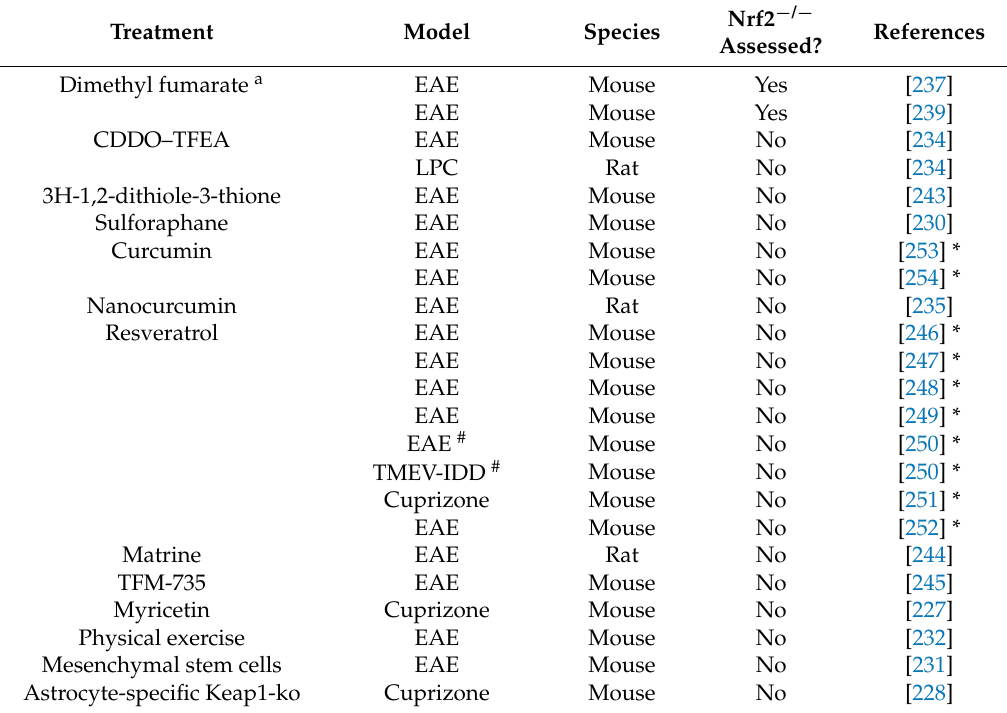
Table 7. Preclinical studies on Nrf2 activation in animal models of multiple sclerosis. Treatment